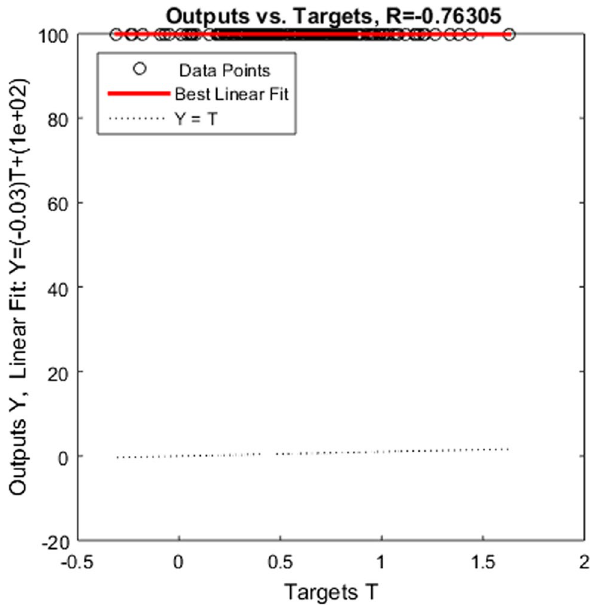
Fig. 10 R 2 (ANFIS) for chromium (VI) removal